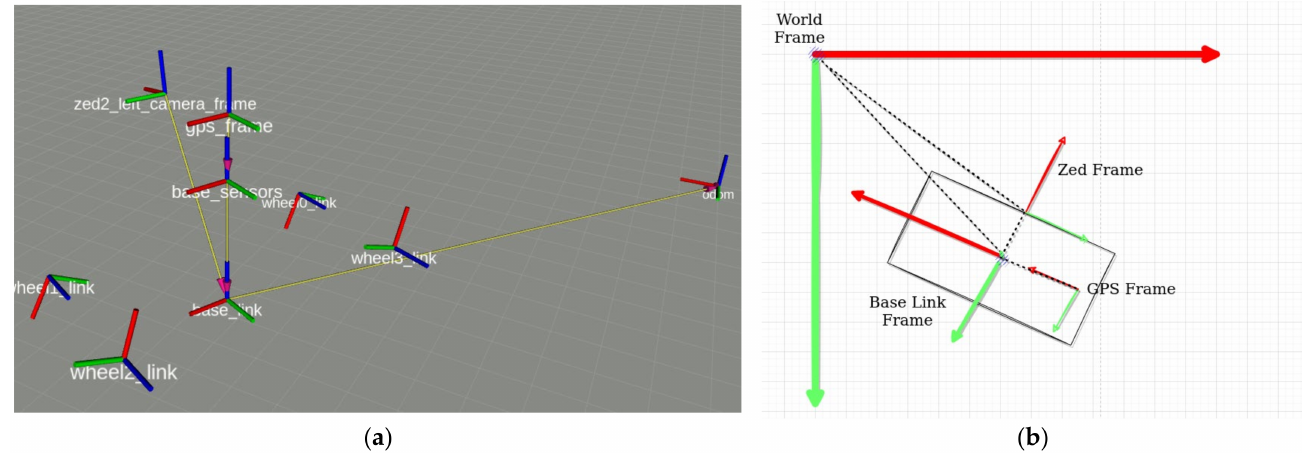
Figure 2. Location and orientation of the RGB-D camera in the relative coordinate system using the IMU ( a ) and georeferencing of the vehicle and the RGB-D to UTM coordinate system ( b